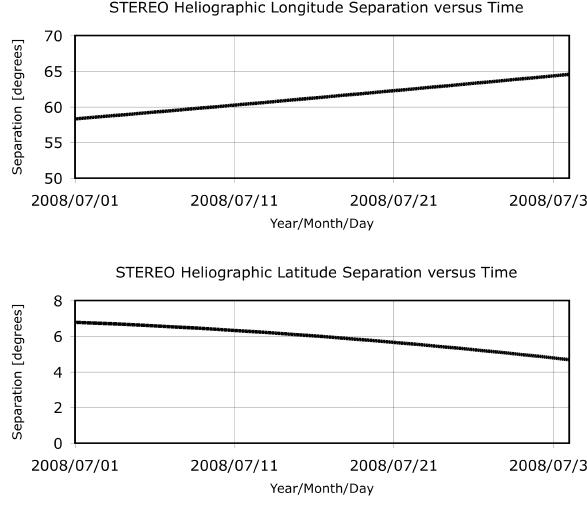
Fig. 1. The STEREO observatories’ separation versus time in heli- ographic longitude (top) and latitude (bottom).